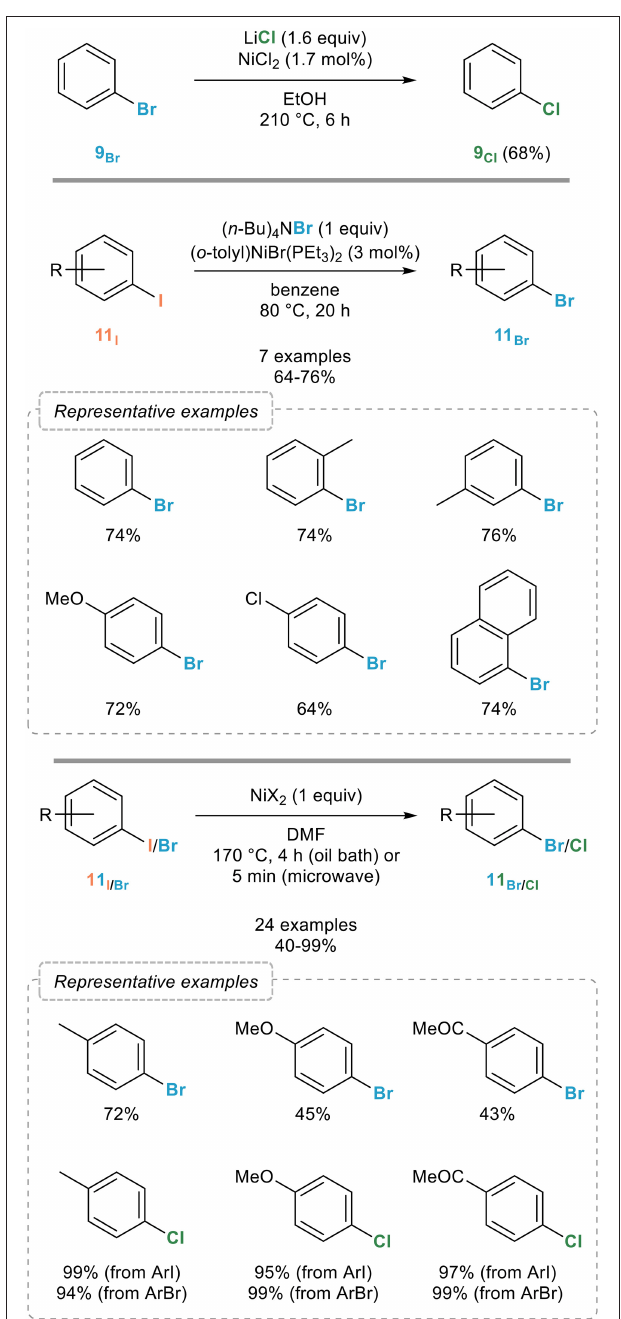
FIGURE 8 | Nickel-catalyzed aromatic retro-Finkelstein reaction.